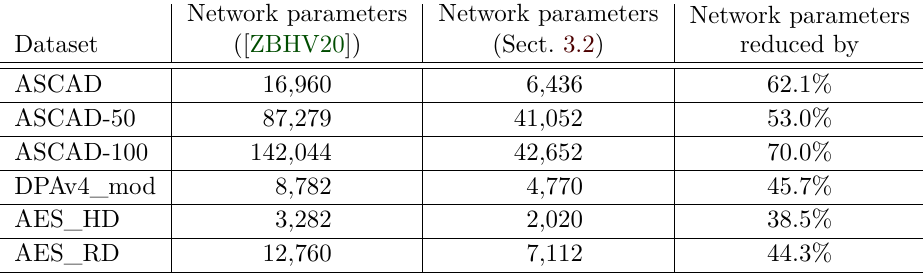
Table 1: The number of trainable parameters for each of the models proposed by Zaid et al. and the number of trainable parameters after removing the first convolutional layer while preserving the first average pooling